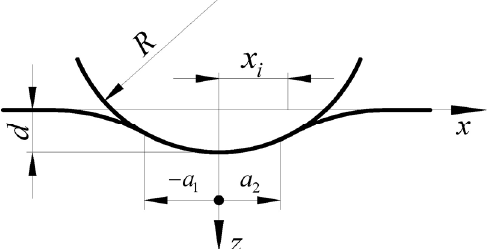
Fig. 3 Scheme of the contact between a cylinder and an elastic